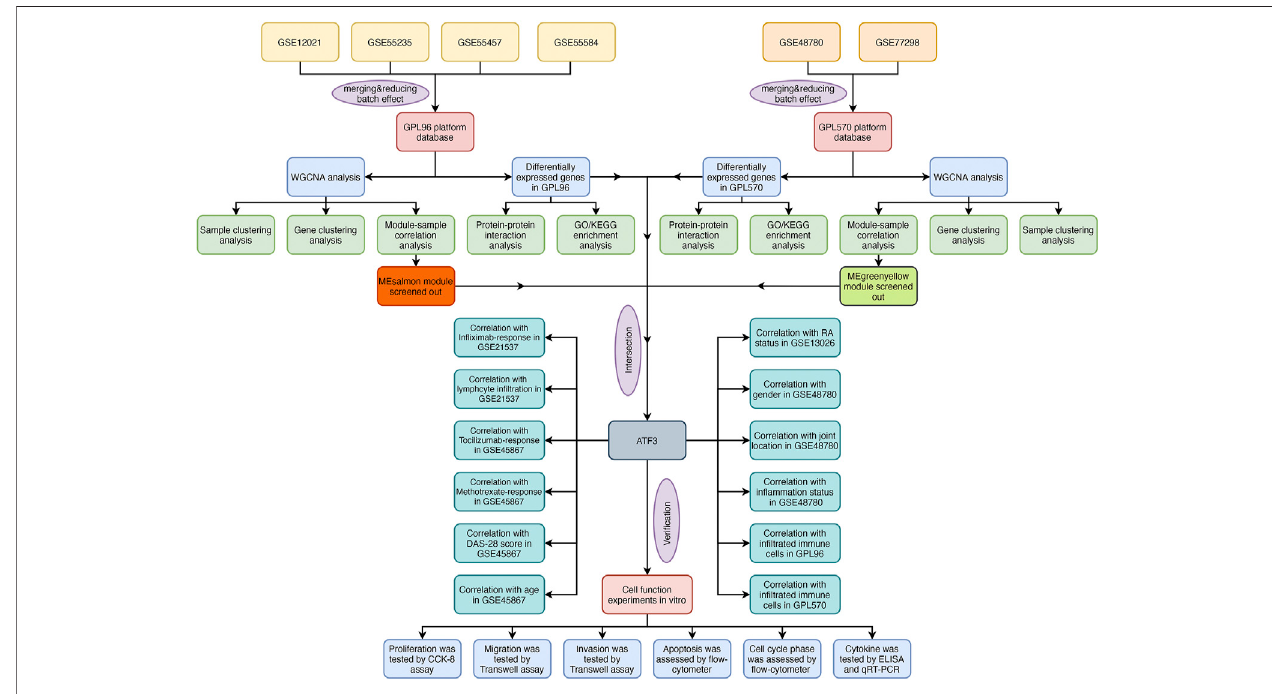
FIGURE 1 | The fl owchart of the